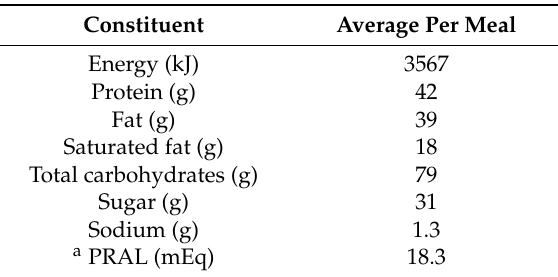
Table 1. Nutritional breakdown of the study meal.